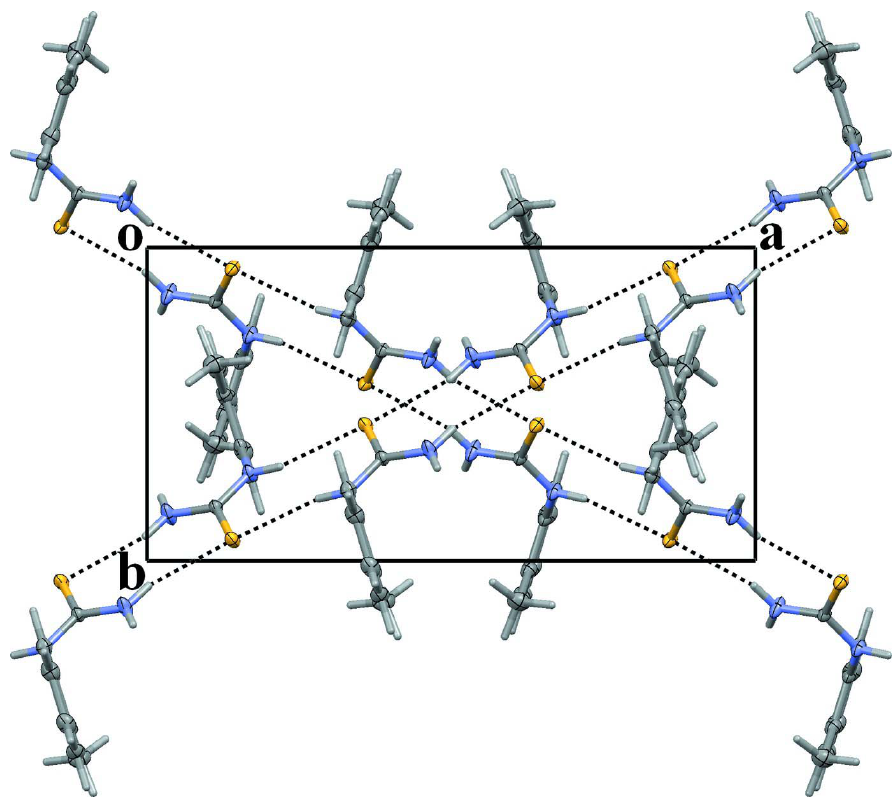
Figure 3 Crystal packing view along c axis showing the two independent